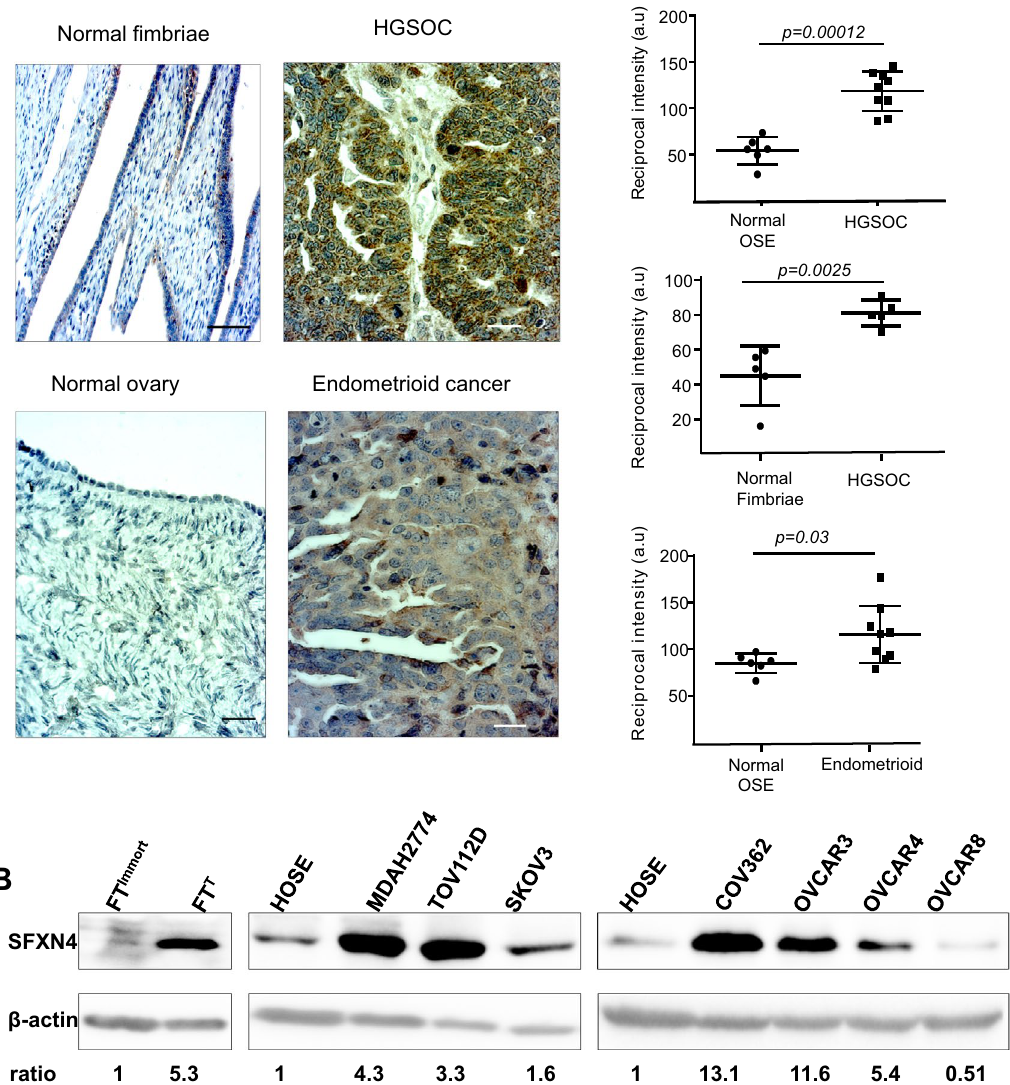
Figure 1. SFXN4 is over expressed in ovarian cancer and ovarian cancer cell lines. ( A ) Representative images of immunohistochemical staining of normal fimbriae and ovarian surface epithelium (OSE), HGSOC, and endometrioid adenocarcinoma stained with anti-SFXN4 antibody. Dot plots represent quantification of staining of tissues collected from 9 patients with HGSOC and endometrioid adenocarcinoma compared to 6 subjects with normal ovarian surface epithelium and five with normal fimbriae. Images of three to four random fields per slide were quantified; each dot represents the average value obtained for an individual patient. Scale bar is 50 µm. ( B ) Immunoblot of SFXN4 from immortalized fallopian tube cells (FT immort ), transformed fallopian tube cells (FT T ), human ovarian surface epithelial (HOSE) cells and the indicated ovarian cancer cells representing different subtypes: endometrioid adenocarcinoma (MDAH2774 and TOV112D), adenocarcinoma (SKOV3) and high-grade serous carcinoma (COV362, OVCAR3, OVCAR4 and OVCAR8). Uncropped images of western blots are presented in Supplemental data (Supplemental Fig.